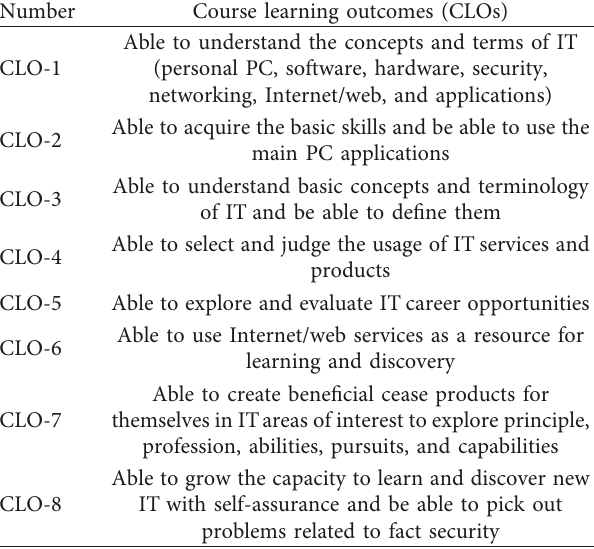
Table 2: Course learning outcomes for IT280.